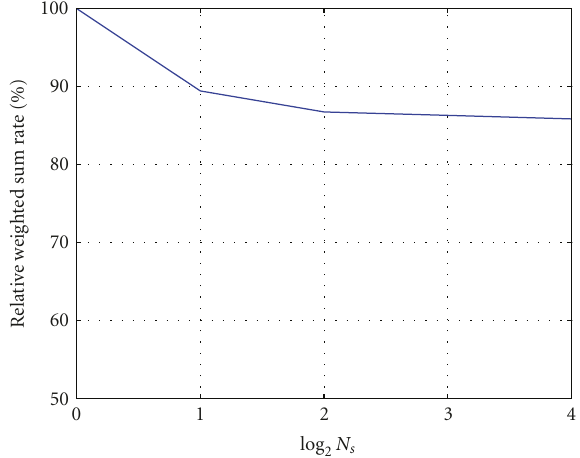
Figure 4: Tradeo ff between reduced complexity and performance degradation of the CDIT-based allocation compared with the perfect